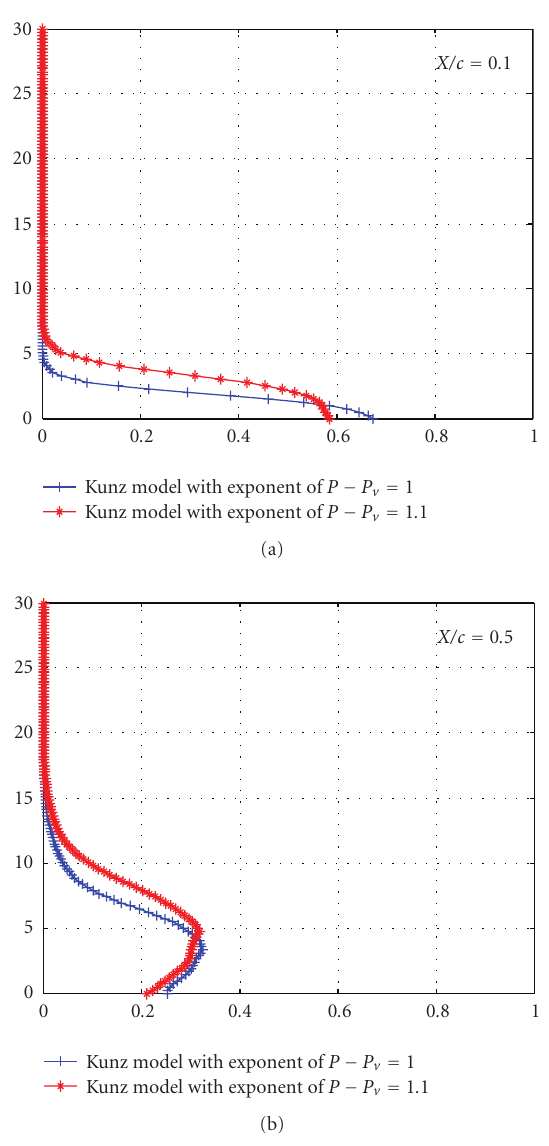
Figure 16: Void Fraction distributions ( L/c = 0 . 8, V ref = 6 m/s).